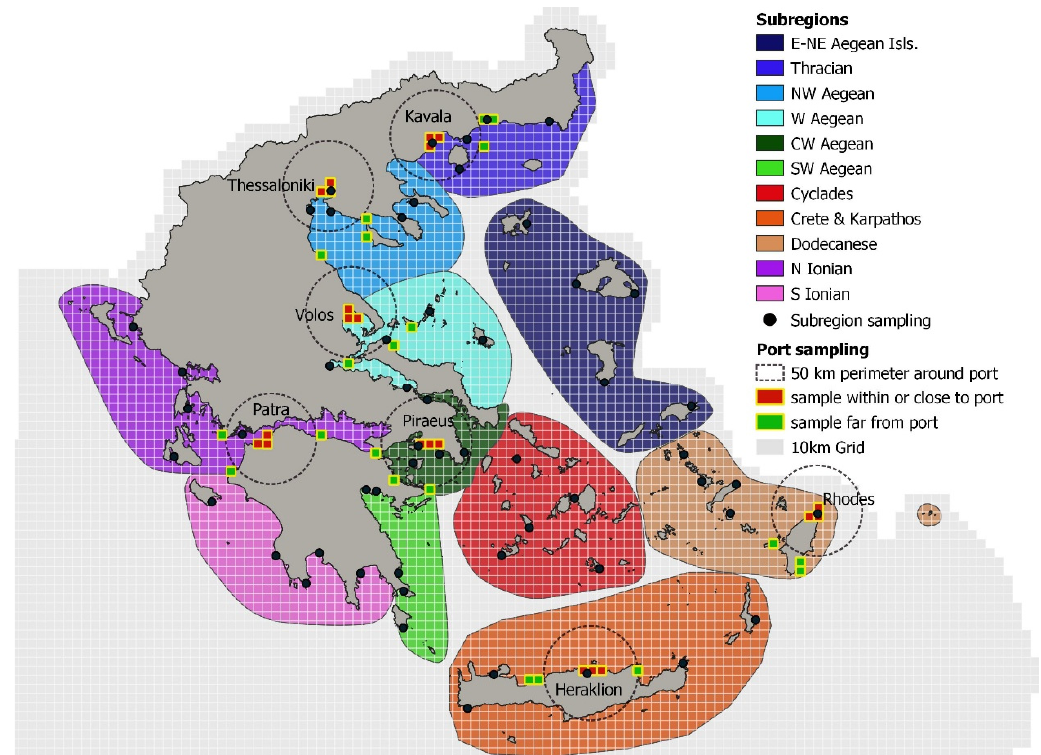
Figure 2. Map of the study area depicting the eleven subregions and the seven largest commercial ports that were used for the spatial analysis regarding community structure and number of reported ICAS in the Greek Seas. Grid cells were produced using the 10 × 10 km European Environmental Agency (EEA) reference grid.